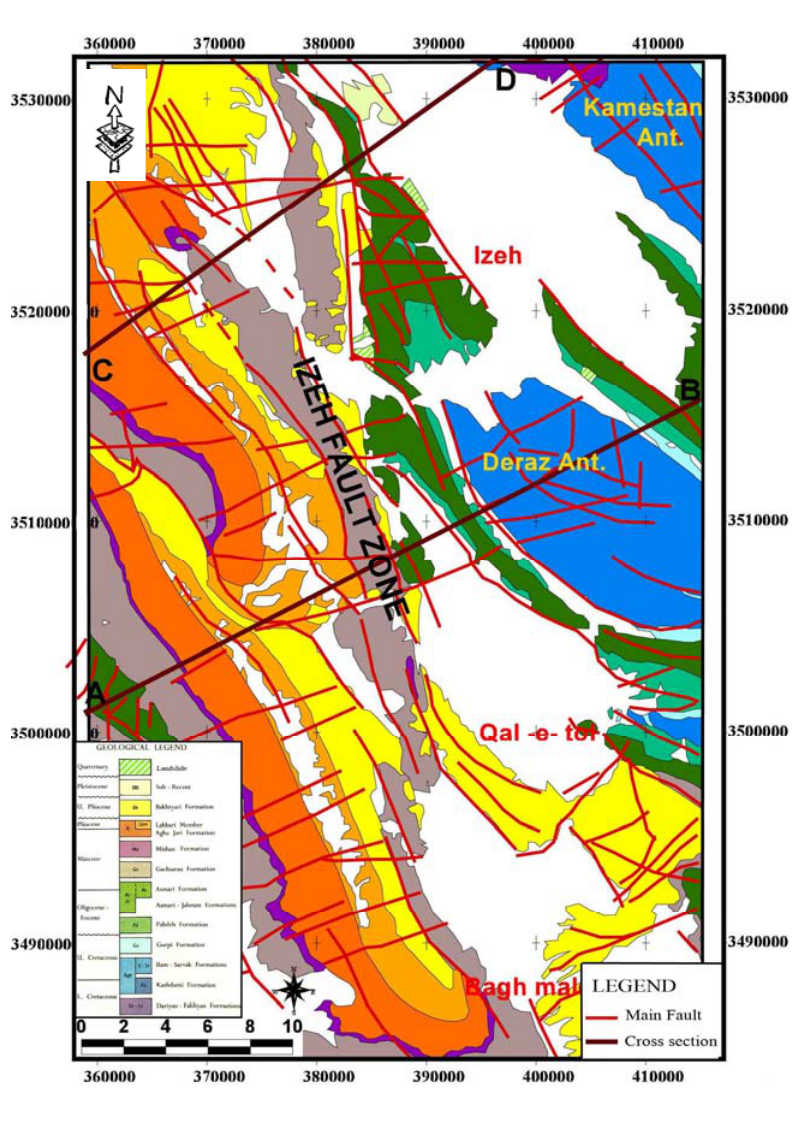
Figure 3. Geology map of the study area with vertical displacement along the Izeh Fault Zone and